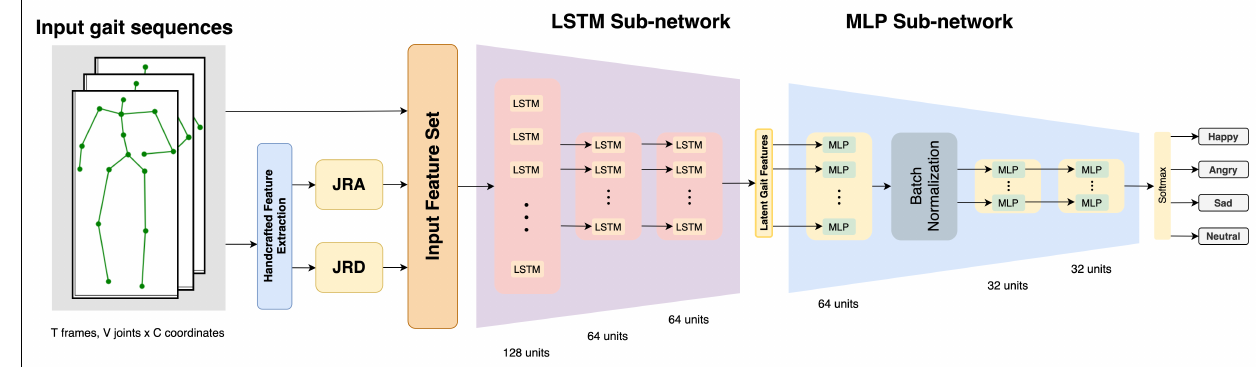
Figure 1. Architecture of the proposed bi-modular sequential neural